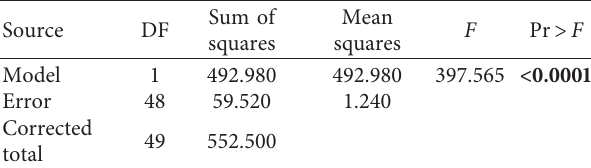
Table 2: ANOVA test of mean scores of solar system. Source DF